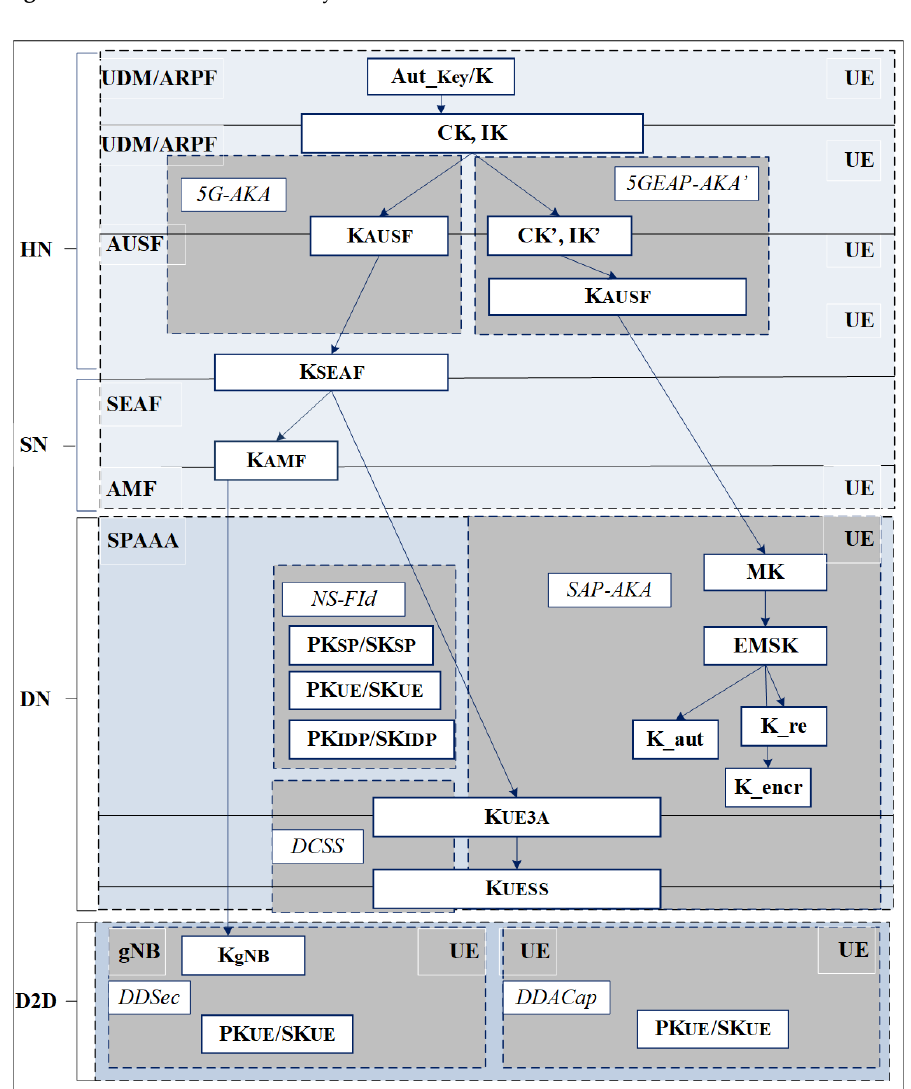
Figure 6. Key Hierarchy and